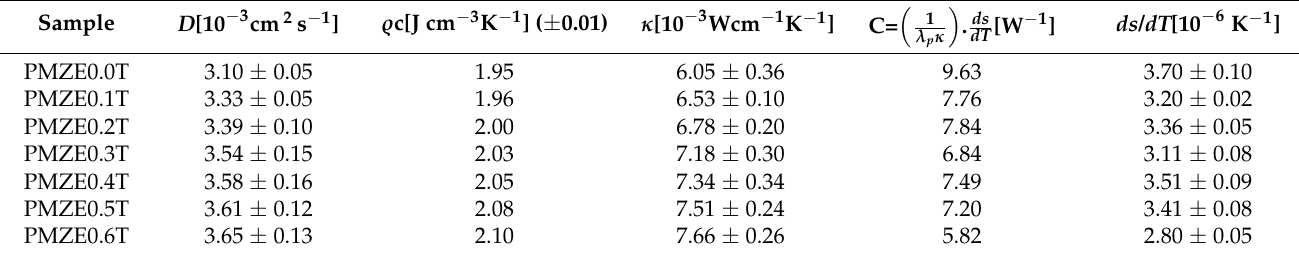
Table 1. Thermal properties of the PMZE + xTiO 2